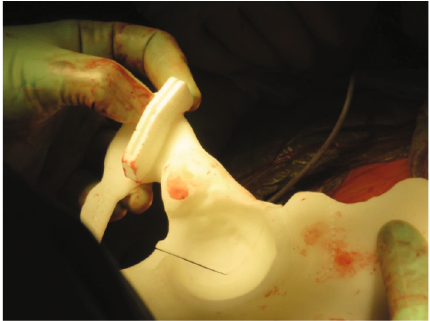
Figure 5: Intraoperative picture showing the veri fi cation of the position of the cutting guide on the 3D-printed model of the patient's